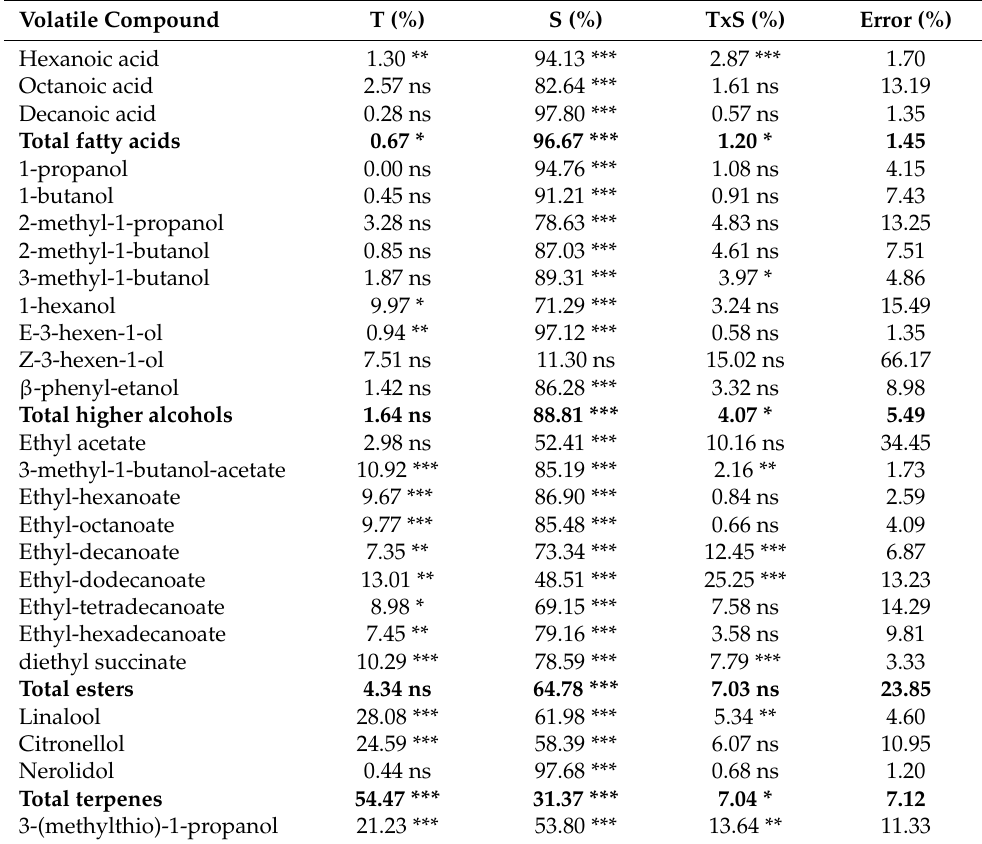
Table 3. Percentage of variance attributable to treatment (T), season (S) and interaction of the variables for each volatile compound concentration in Monastrell